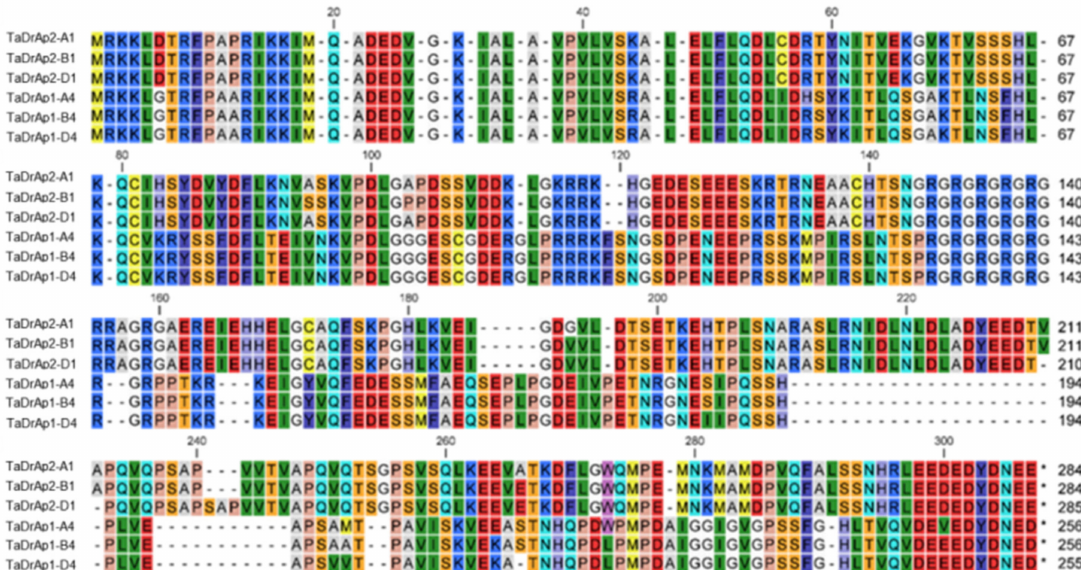
Figure 1. ClustalW analysis of amino acid comparisons between homeologs of two down-regulator associated proteins, TaDrAp1 and TaDrAp2, from the Gramene database with sequence of cv. Chinese Spring, using CLC Main Workbench